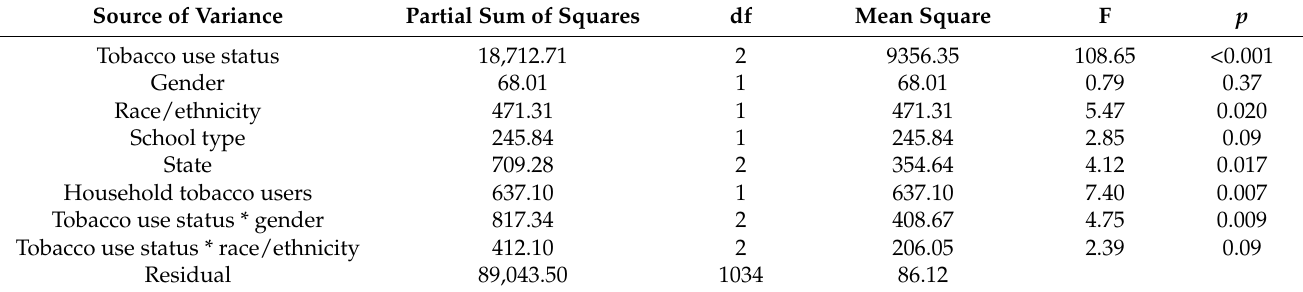
Table 4. Factorial ANOVA of Main and Interaction Effects of Sociodemographic Characteristics and Tobacco Use Status on Temptation to Use E-cigarettes.